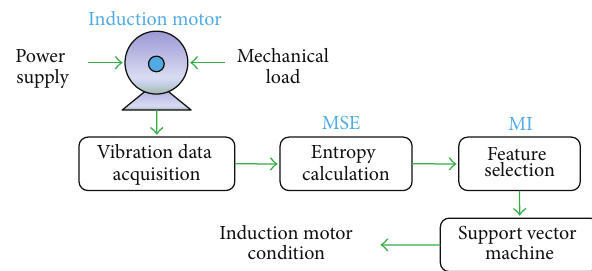
Figure 1: The flowchart of the fault diagnosis algorithm for induc- tion